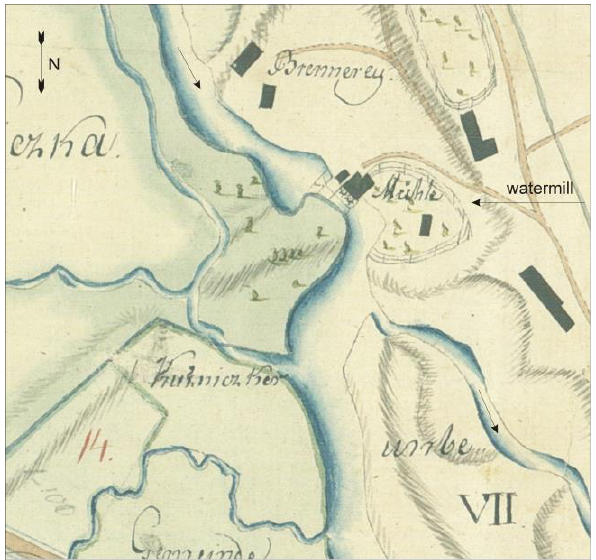
Fig. 4. Section of the Kuźniczka village plan from 1810 with a multi-channel reach of the River Liswarta and a watermill with two wheels (source: Wermessungs-Plan…, 1810, original scale ca. 1:12,000, AGAD, ZK 402, Ref. No.